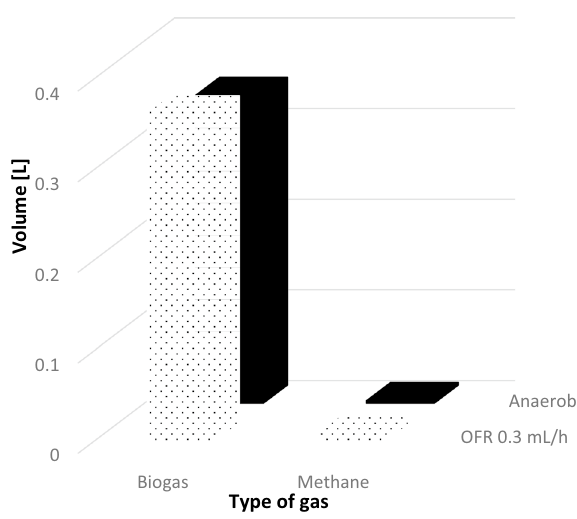
Fig. 3 Total biogas and methane production fermentation process stimulated by pretreated inoculum, T = 43 °C for OFR ~ 0.3 mL/h